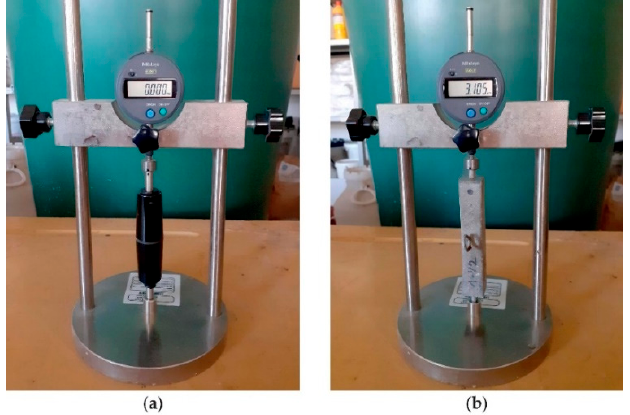
Figure 7. ( a ) Instrument verification using a calibration rod; ( b ) test specimen length measurement.